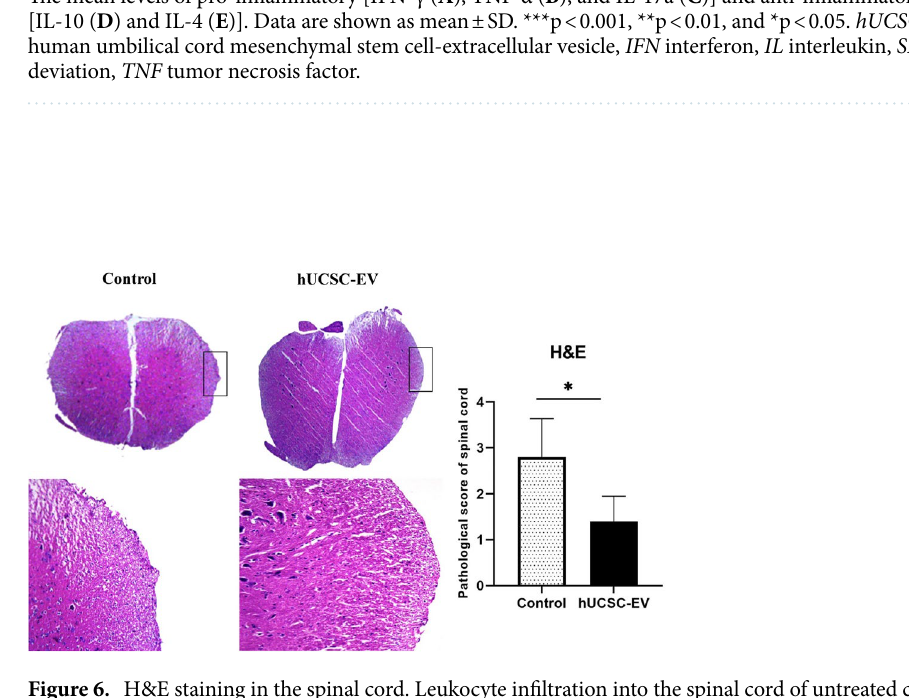
Figure 6. H&E staining in the spinal cord. Leukocyte infiltration into the spinal cord of untreated control, hUCSC-EVs-treated groups were assessed using H&E stating. Data are shown as mean ± SD. *p < 0.05. H&E hematoxylin and eosin, hUCSC-EV human umbilical cord-derived mesenchymal stem cell-extracellular vesicle, SD standard